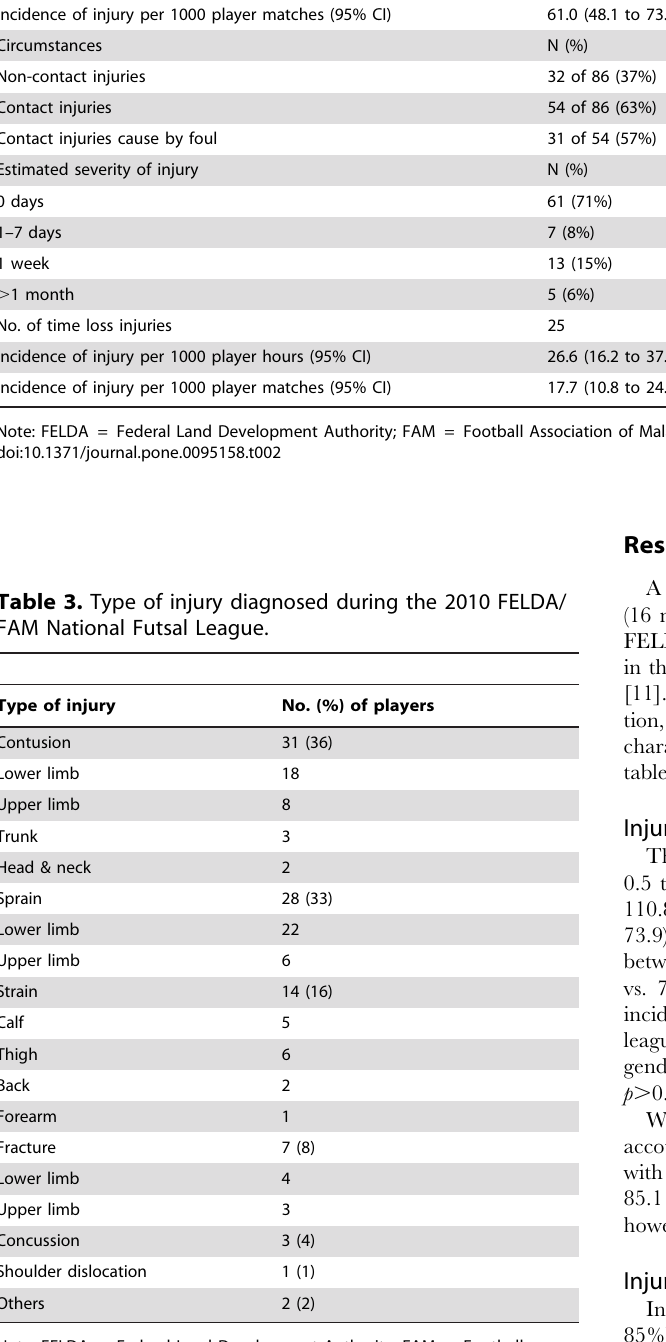
In this study most injuries were classified as new injury (n= 73; 85%). The commonest injury diagnosed was contusion (n= 31; 36%) followed by ligament sprains and muscle strains (Table 3). Majority of contusions (n= 27; 87.1%) did not result in time-loss